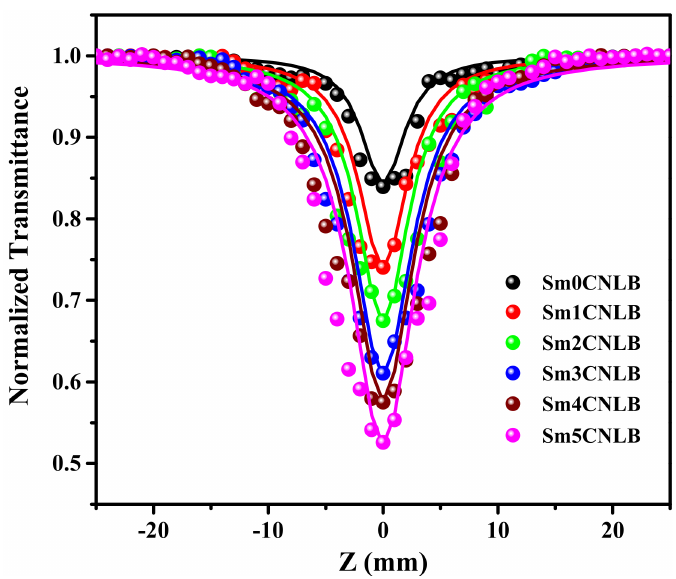
Figure 2. OA Z-scan outcomes of studied Sm x CNLB glasses, where x = 0, 1, 2, 3, 4 and 5 mol %. The symbols and solid lines indicate the experimental and theoretical OA Z-scan data,